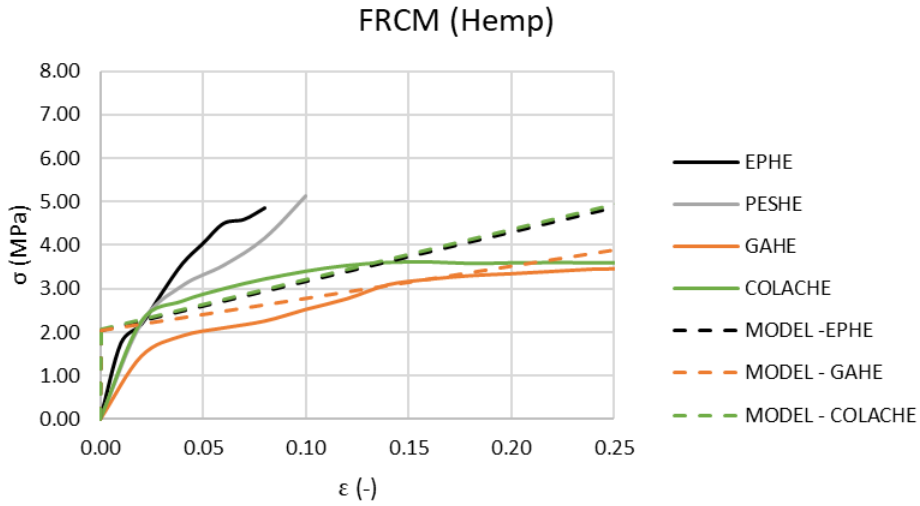
Figure 11. Stress–strain curves for cotton FRCM, analytical and experimental. Figure 11. Stress – strain curves for cotton FRCM, analytical and experimental.